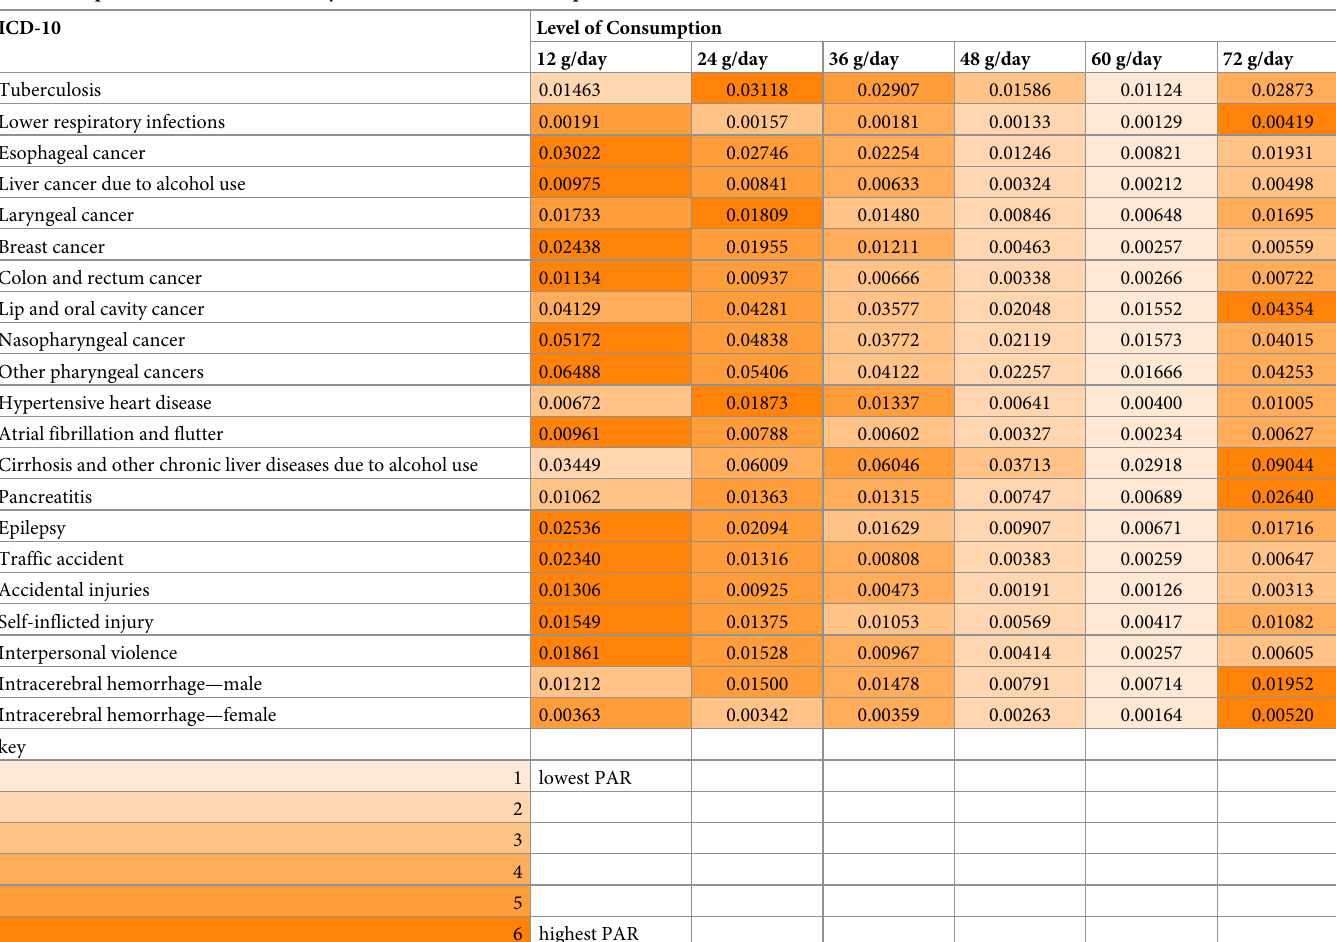
Table 3. Population Attributable Risk by ICD-10 and level of